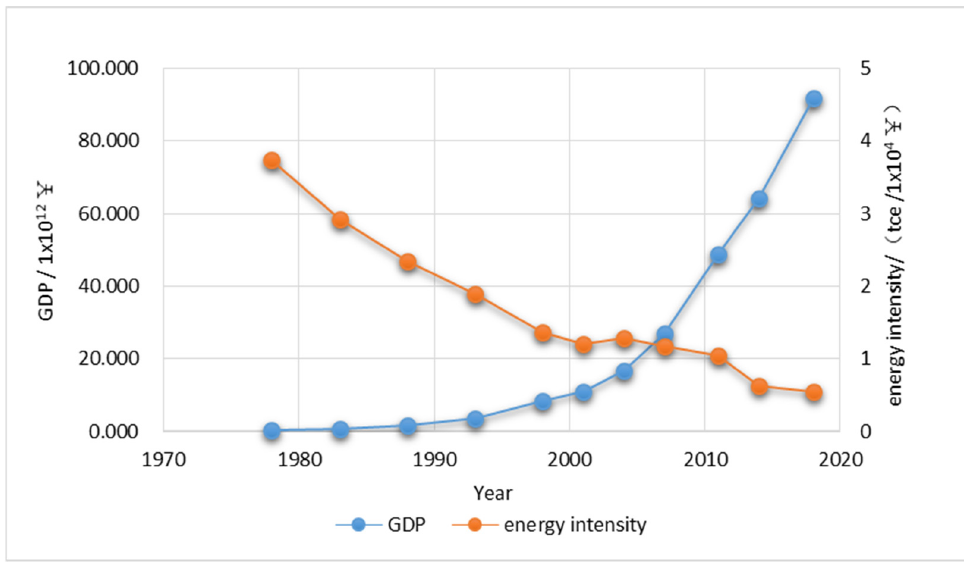
Figure 3. Trend chart of GDP and energy intensity in China.